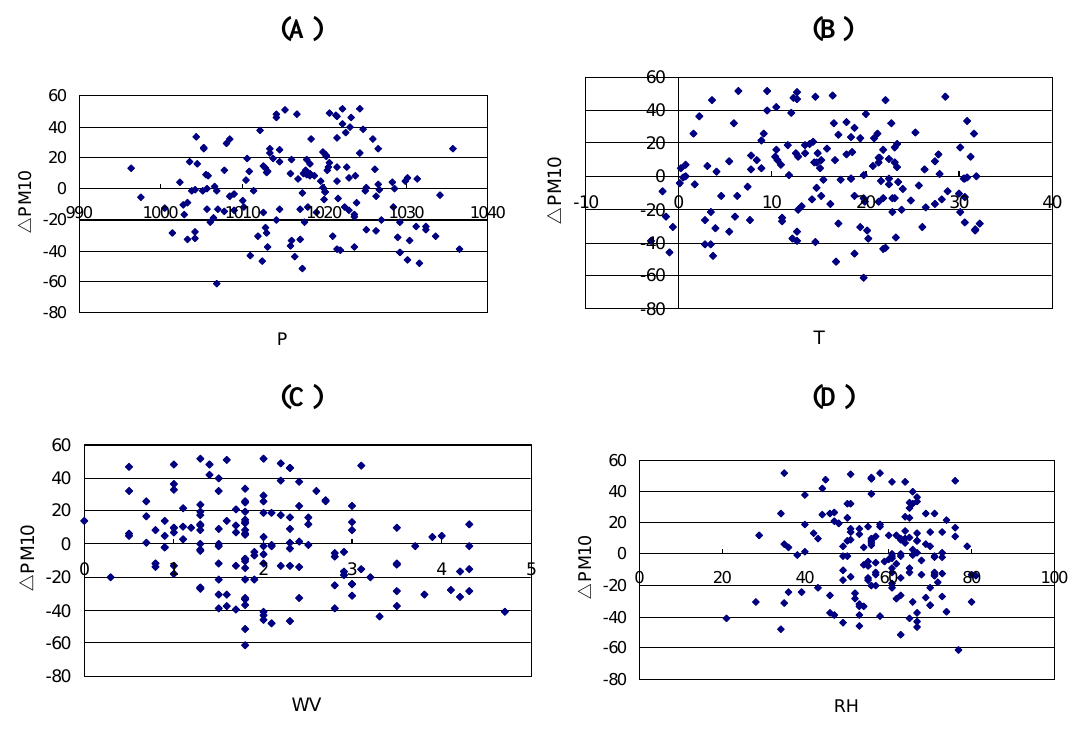
Figure 3. Scatterplots of residuals of PM individual meteorological parameters. (A) air pressure; (B) air temperature; (C) wind velocity; and (D) relative